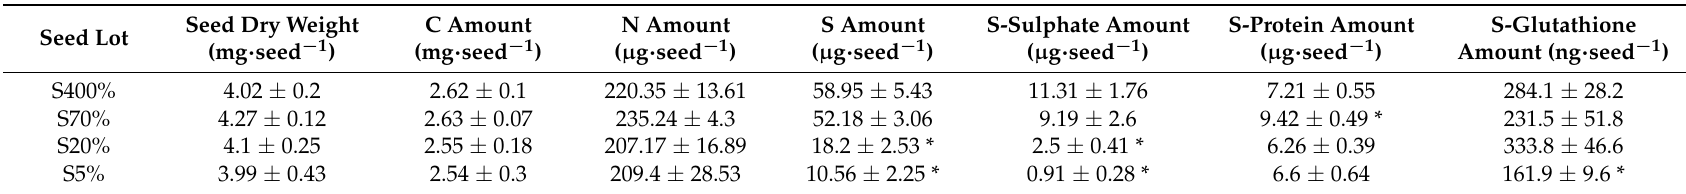
Table 1. Seed dry weight and amounts of C, N, S, S-sulphate, S-protein and S-glutathione in mature Brassica napus seeds obtained from plants well-supplied with S and grown under S-limited conditions. Values correspond to means ± standard error (SE) (n = 3). Seeds (without fragments and aborted seeds) were obtained from plants subjected to plethoric S nutrition (400% of plant S needs provided, S400% seeds) or subjected to a S limitation from the beginning of plant growth with 70%, 20% and 5% of plant S needs provided (S70%, S20% and S5% seeds, respectively).